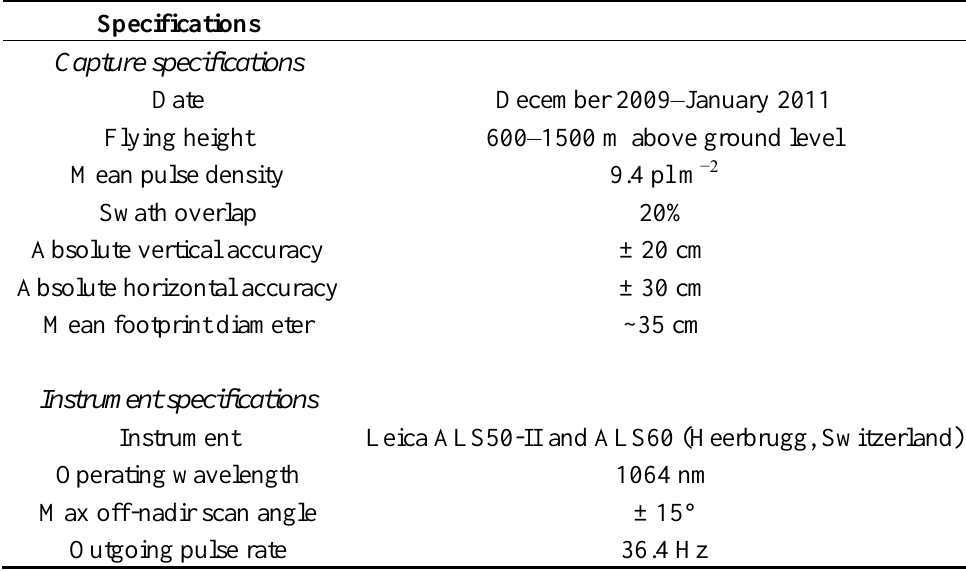
Table 1. ALS capture and instrument